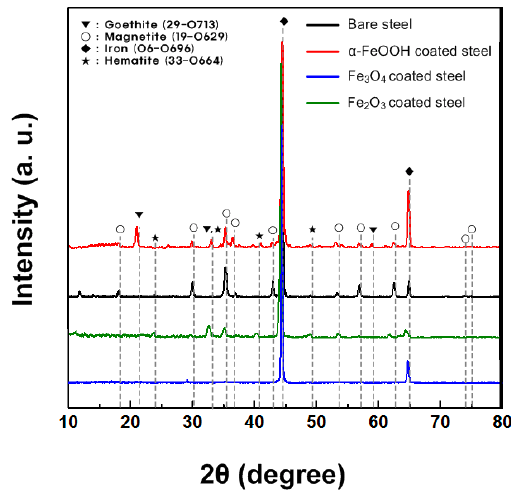
Figure 11. X-ray diffraction (XRD) spectra for the specimens covered with iron oxides and uncovered which were immersed in the simulated district heating water for 340 h at 40 ◦ C ( (cid:72) : goethite, α